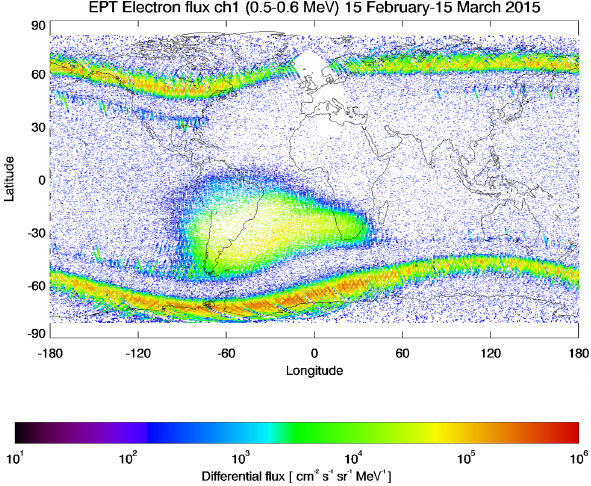
Figure 8. Map of the electron fluxes observed by EPT/PROBA-V in Channel 1 between 15 February and 15 March 2015 (before the event).